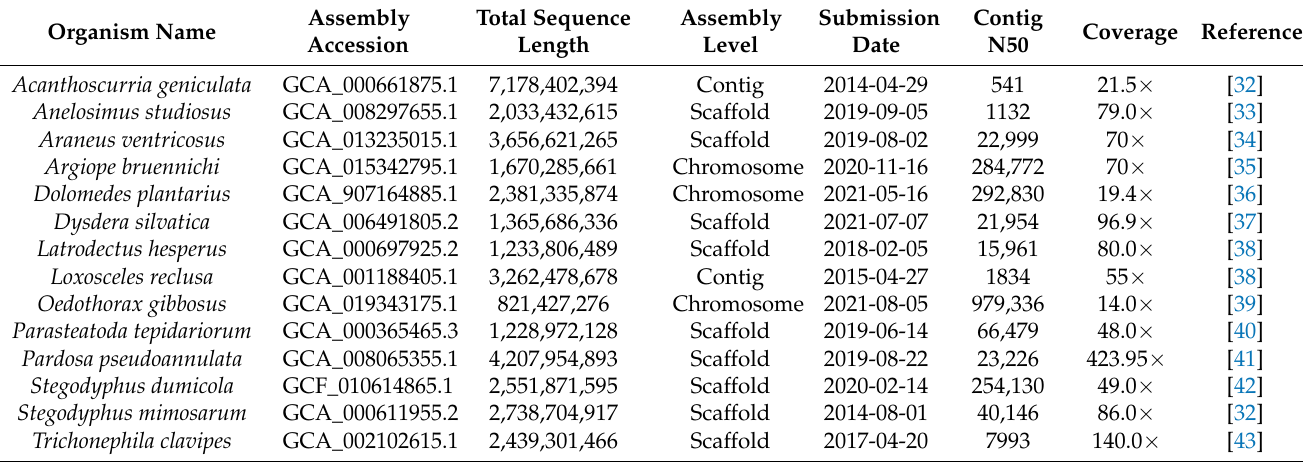
Table 1. Genomes fetched from GenBank. Information for all 14 genomes used in this research, which were fetched from GenBank. This table displays species name, assembly accession, assembly level, assembly submission date, N50 of contigs, coverage rate, and references for each genome. Adding Argyrodes miniaceus , 15 genomes are included in this